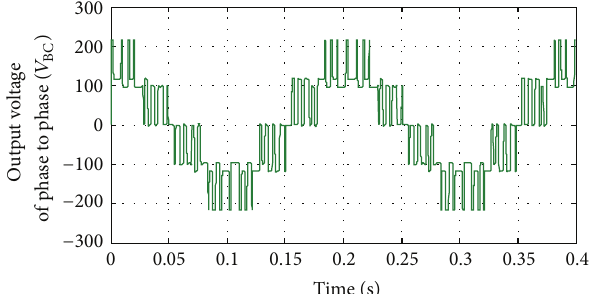
Figure 13: Current of DC-DC converter’s inductance.